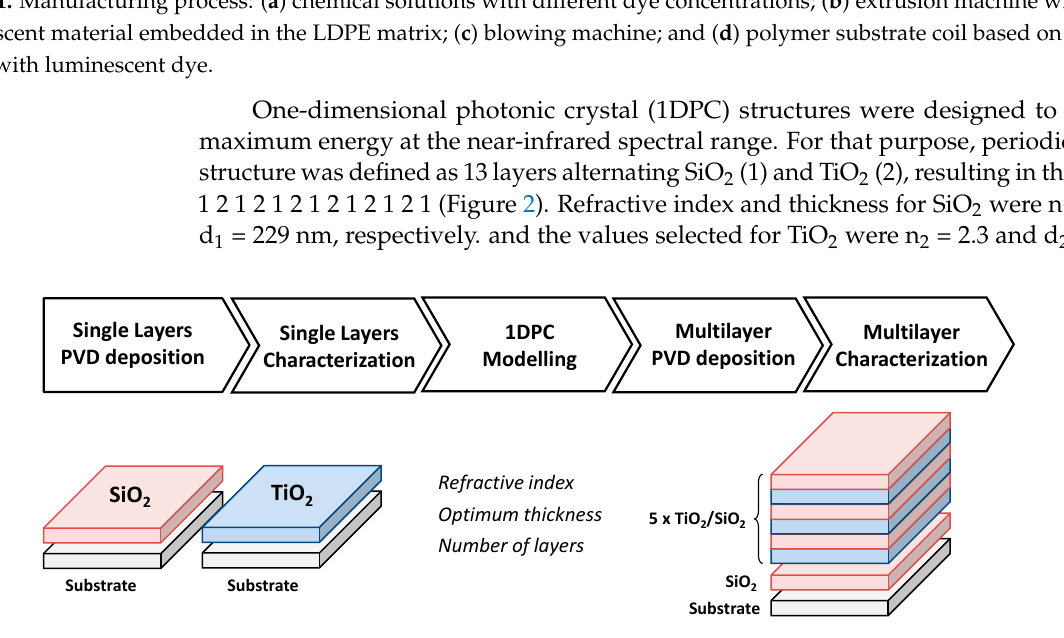
Figure 1. Manufacturing process: ( a ) chemical solutions with different dye concentrations; ( b ) extrusion machine with the luminescent material embedded in the LDPE matrix; ( c ) blowing machine; and ( d ) polymer substrate coil based on LDPE doped with luminescent dye.